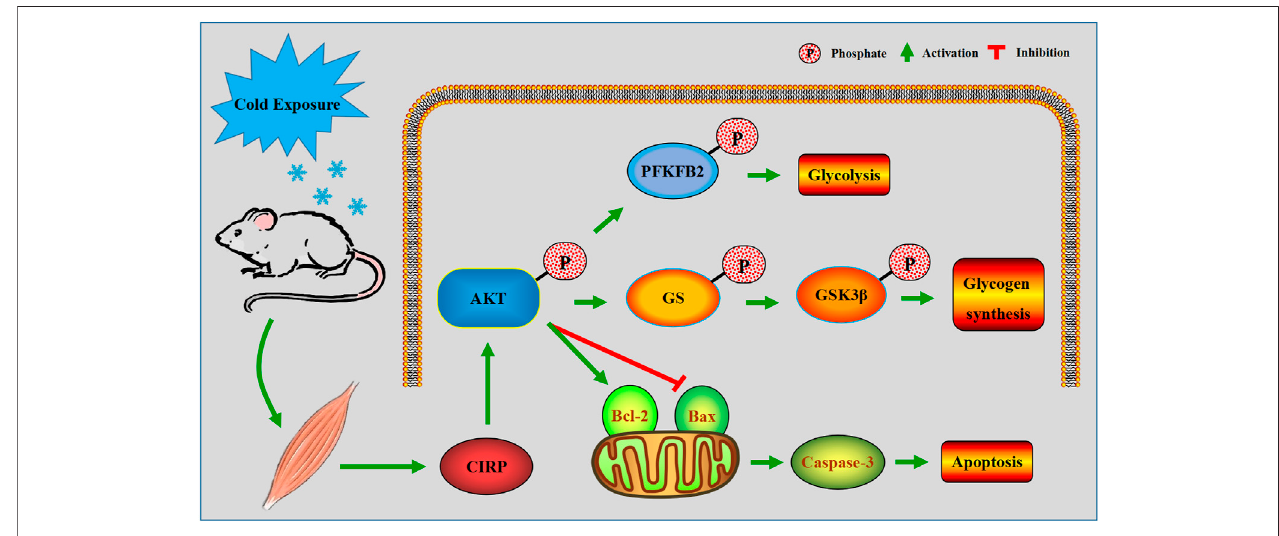
FIGURE 10 | A model of the regulatory mechanism of CIRP in skeletal muscle of mice with acute cold exposure. Arrows indicate promotion, and T-bars indicate